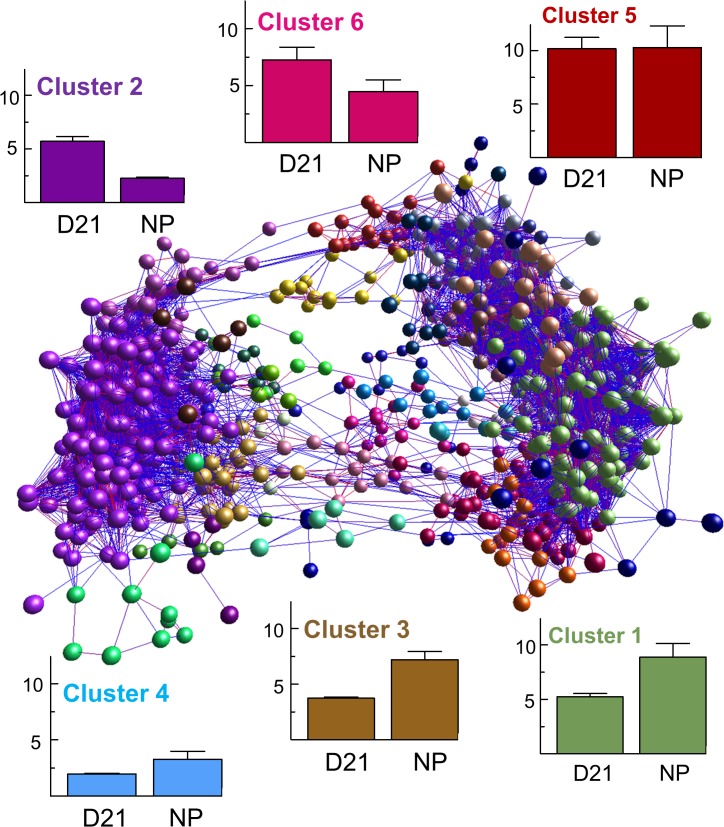
Biolayout Express
3D analyses of Mφ gene expression and clustering analyses.Data were transposed in an analysis to identify correlations among groups based on individual gene expression levels (Pearson’s correlation of R≥0.9 and intensity >1 of dataset with fold >2 or <-2 and p<0.01). Markov clustering (MCL, inflation = 1.7) was used to identify clusters related to Mφ genes (microarray results from whole divided by Mφ -depleted cervix). These clusters were analyzed again to create the network schema with 1418 nodes and 69761 edges. Color of nodes represents membership in clusters. The 5 largest MCL clusters had distinct patterns that represent 80% of differentially regulated Mφ genes in cervix (histogram insets, average intensity ± SE, n = 3 rats/group).